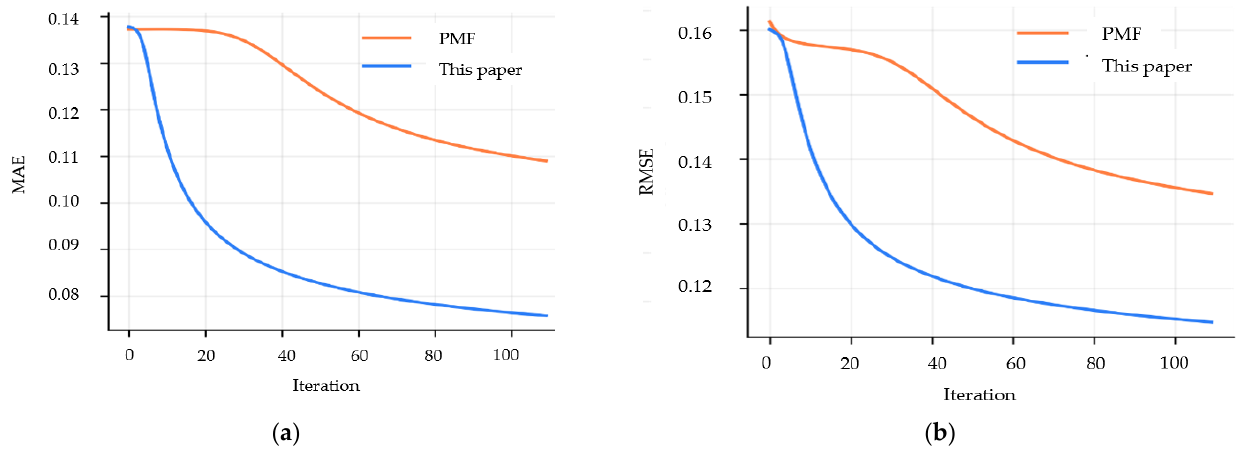
Figure 6. Comparison between the proposed algorithm and PMF algorithm under MAE ( a ) and RMSE ( b ).